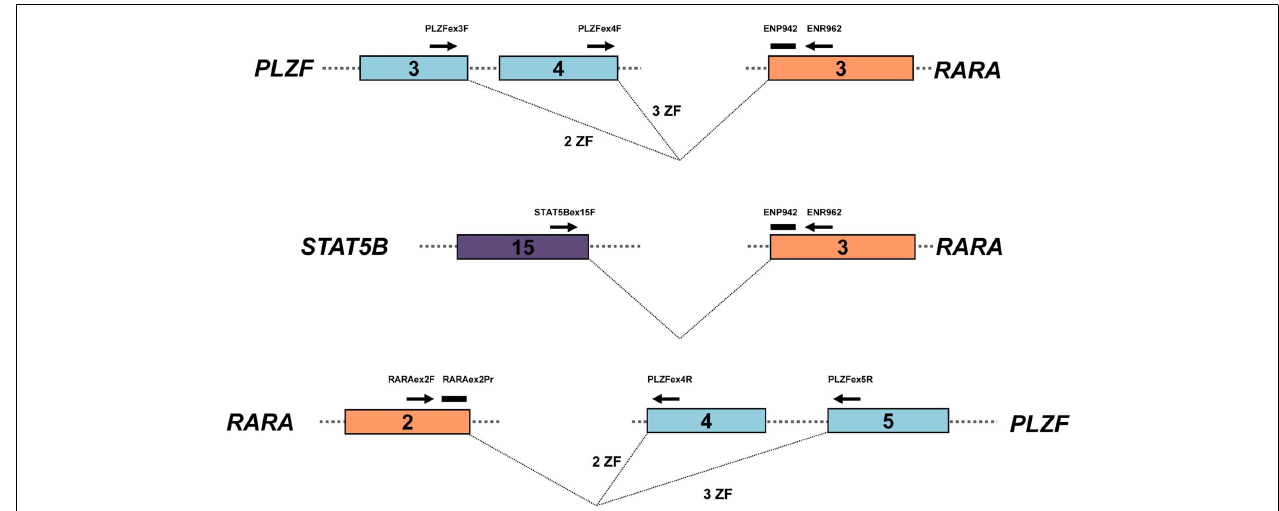
which the breakpoint fell within intron 4 (retaining 3 ZF in the PLZF moiety of PLZF–RAR α ), the forward primer was located within exon 4 (upper panel). For amplification of STAT5b–RARA , the forward primer was placed in STAT5b exon 15 (middle panel). In UPN1, UPN3, and UPN5, reciprocal RARA–PLZF transcripts were co-expressed; RT-qPCR assays were designed for this target using a previously published common forward primer and probe located in RARA exon 2 (Grimwade et al., 2009), used in conjunction with a reverse primer located in PLZF exon 4 or 5, according to chromosome 11 breakpoint location (bottom panel).